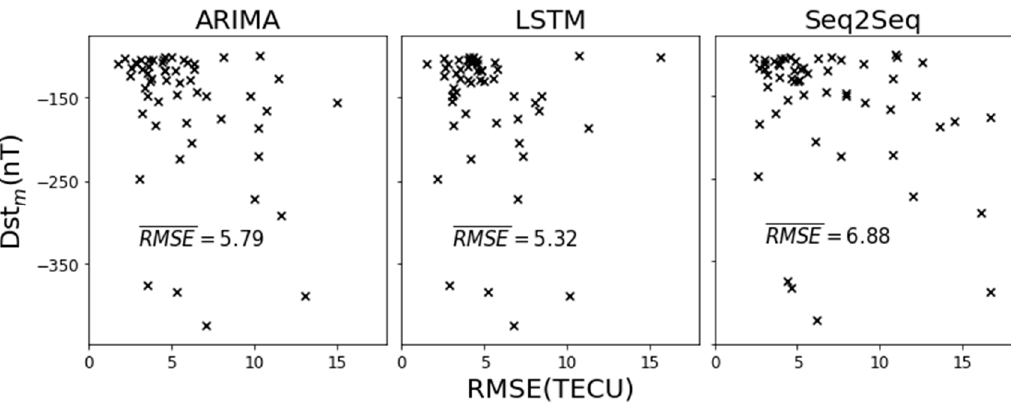
Figure 7. The average of the root mean square error ( RMSE ) between the observed and predicted values (x-axis) against the minimum Dst index of the main phase (y-axis) for the 55 magnetic storm events that occurred between 2001 and 2016 (shown by the cross in the figure).